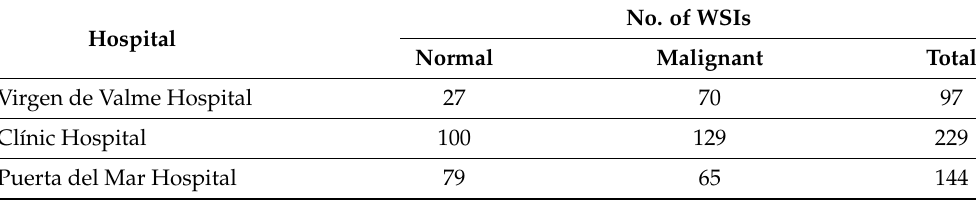
Table 1. Dataset